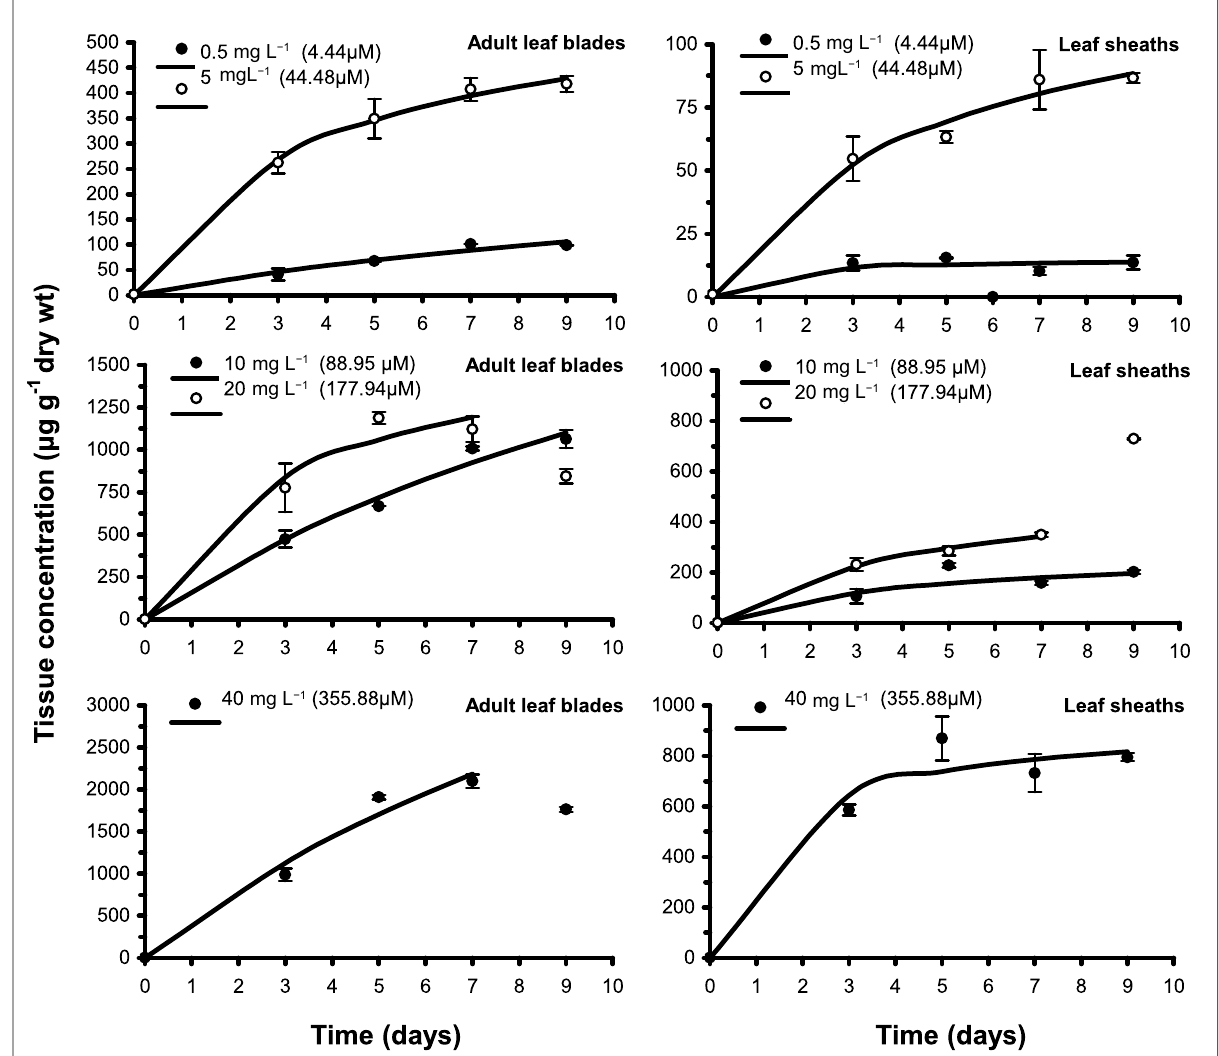
Fig. 1 Kinetics of cadmium accumulation in adult leaf blades and leaf sheaths of Cymodocea nodosa at different concentrations of cadmium in water. Values plotted are mean tissue concentration standard error (n 3); bold lines are the accumulation kinetics calculated using a Michaelis–Menten‑type ± =